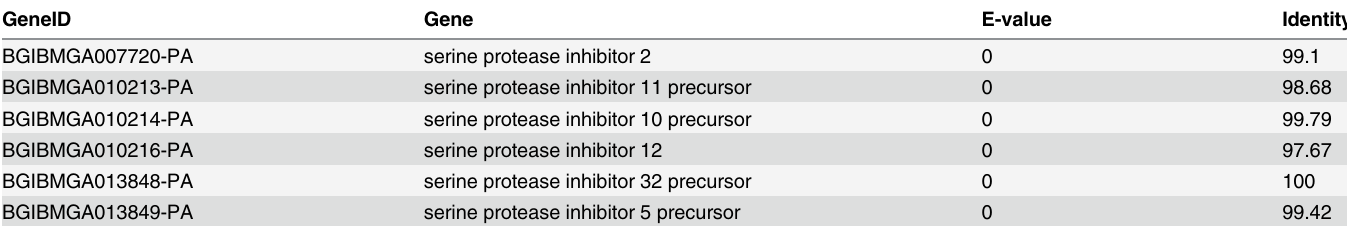
Table 4. Genes associated with endopeptidase inhibitor activity up-regulated in ASG. GeneID